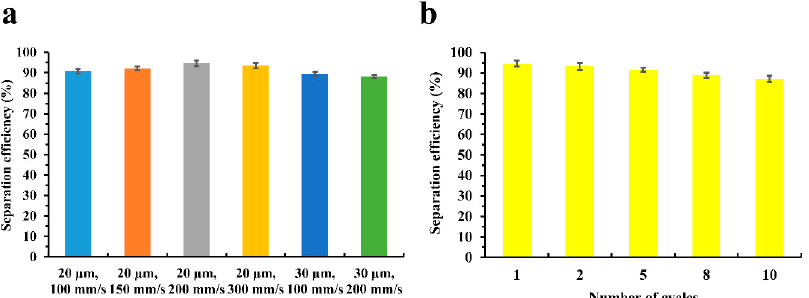
Figure 12. Separation efficiency of the laser-heat treated Cu foams with ( a ) different laser processing parameters and ( b ) multiple cycles.